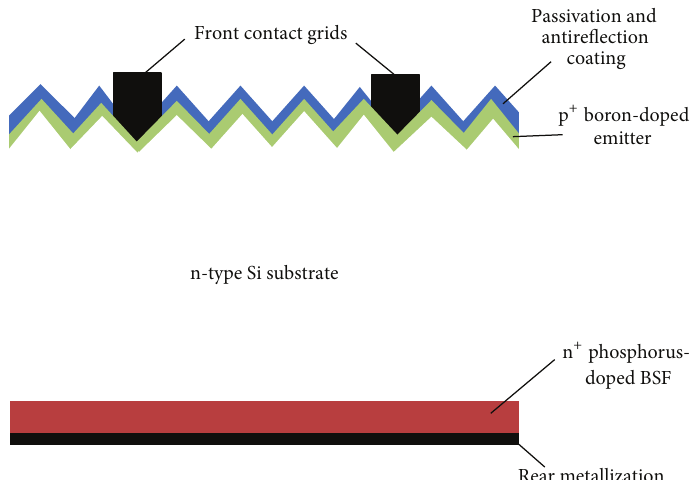
Figure 4: Cross-section of p + nn + structured solar cell. The emitters of such solar cells are usually formed by boron diffusion process. The n +